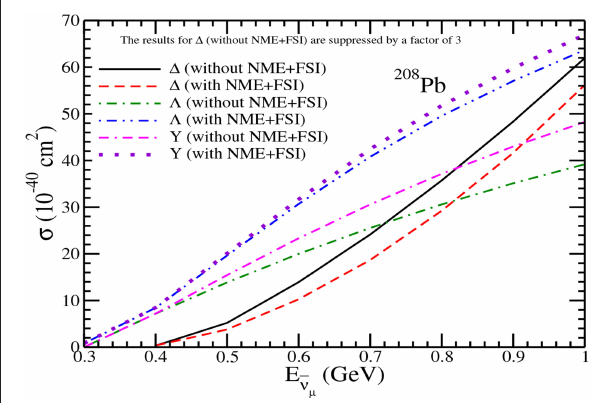
FIGURE 19 | Results for π o production in 208 Pb. Lines and points have the same meaning as in Figure 16 . Notice that the results of 1 without NME+FSI are suppressed by a factor of